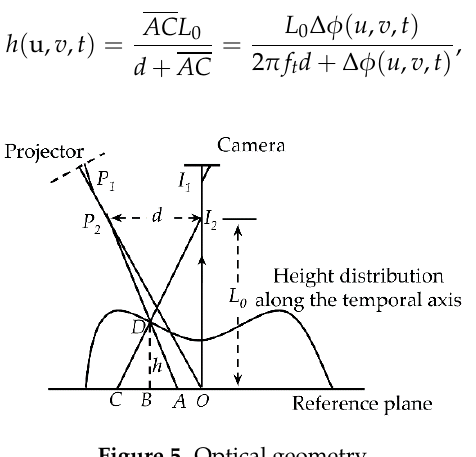
Figure 5. Optical geometry.